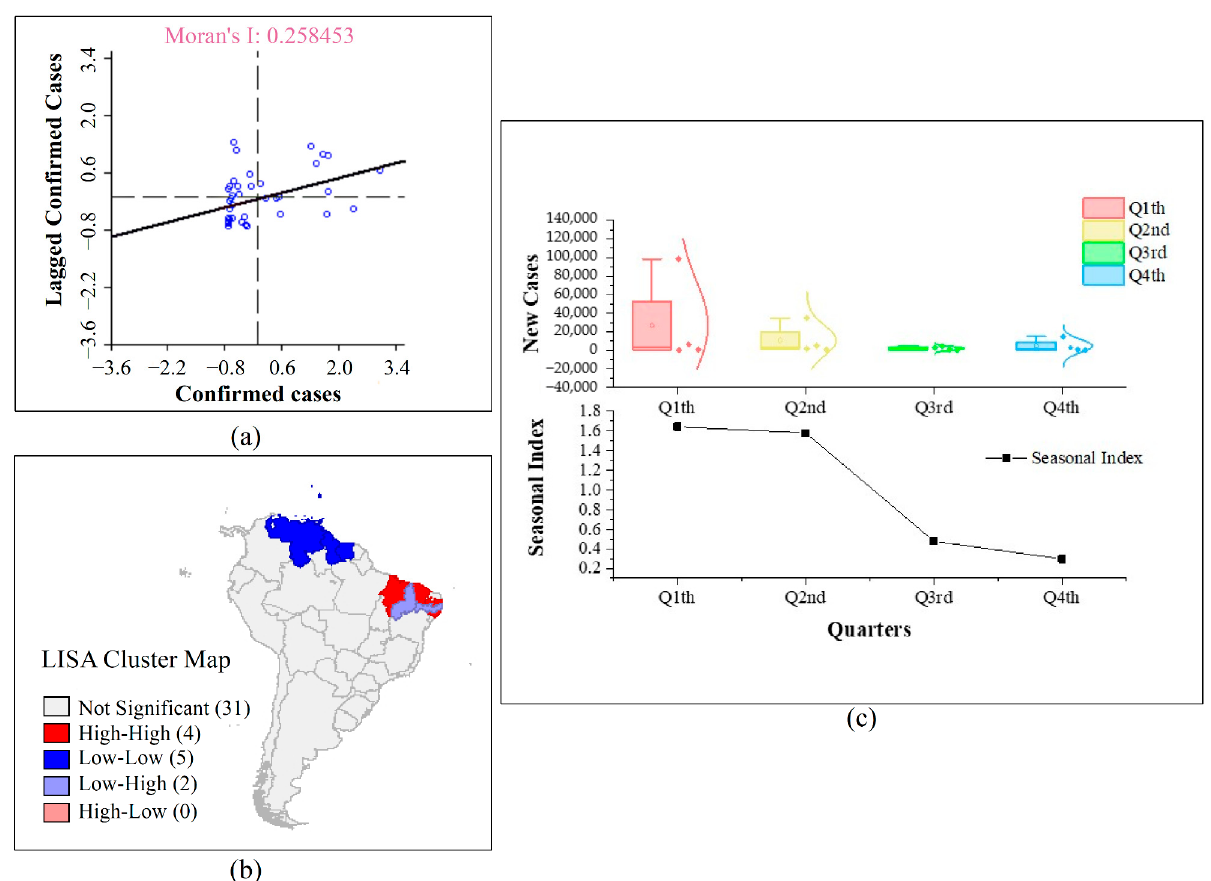
Figure 6. Spatial correlation in South America. The sub-graph ( a – c ) represent Moran index, LISA Cluster Map and seasonal index of four quarters respectively.